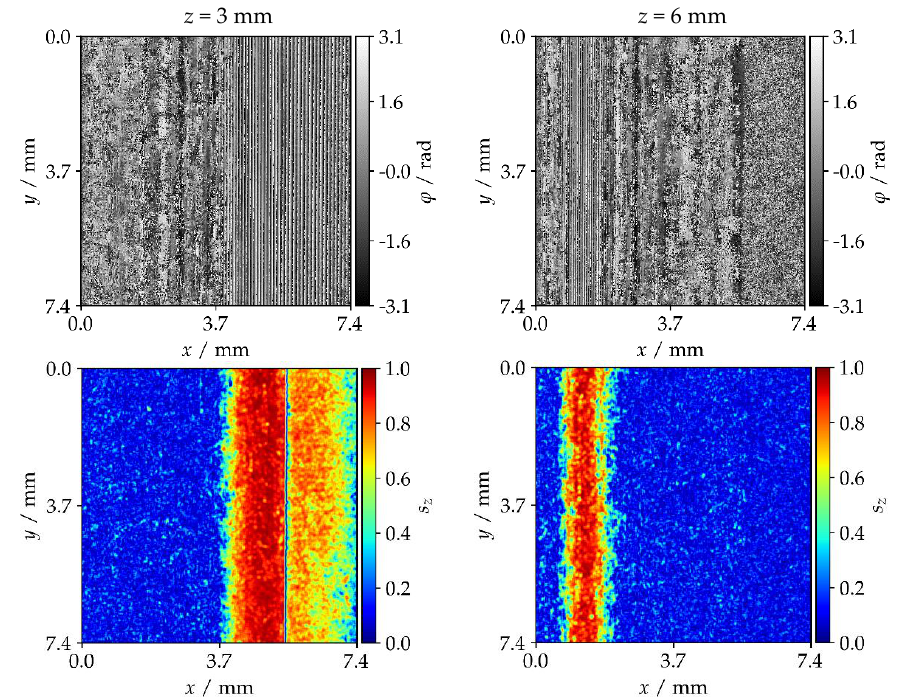
Figure 5. Phase 𝜑 (left/right) and phase smoothness 𝑠 𝑧 for two propagation distances 𝑧 . Left: 𝑧 = 3 mm, right: 𝑧 = 6 mm. Sharp stripes can be observed in areas of low phase noise, whereas areas of high phase noise appear as random phase distribution.